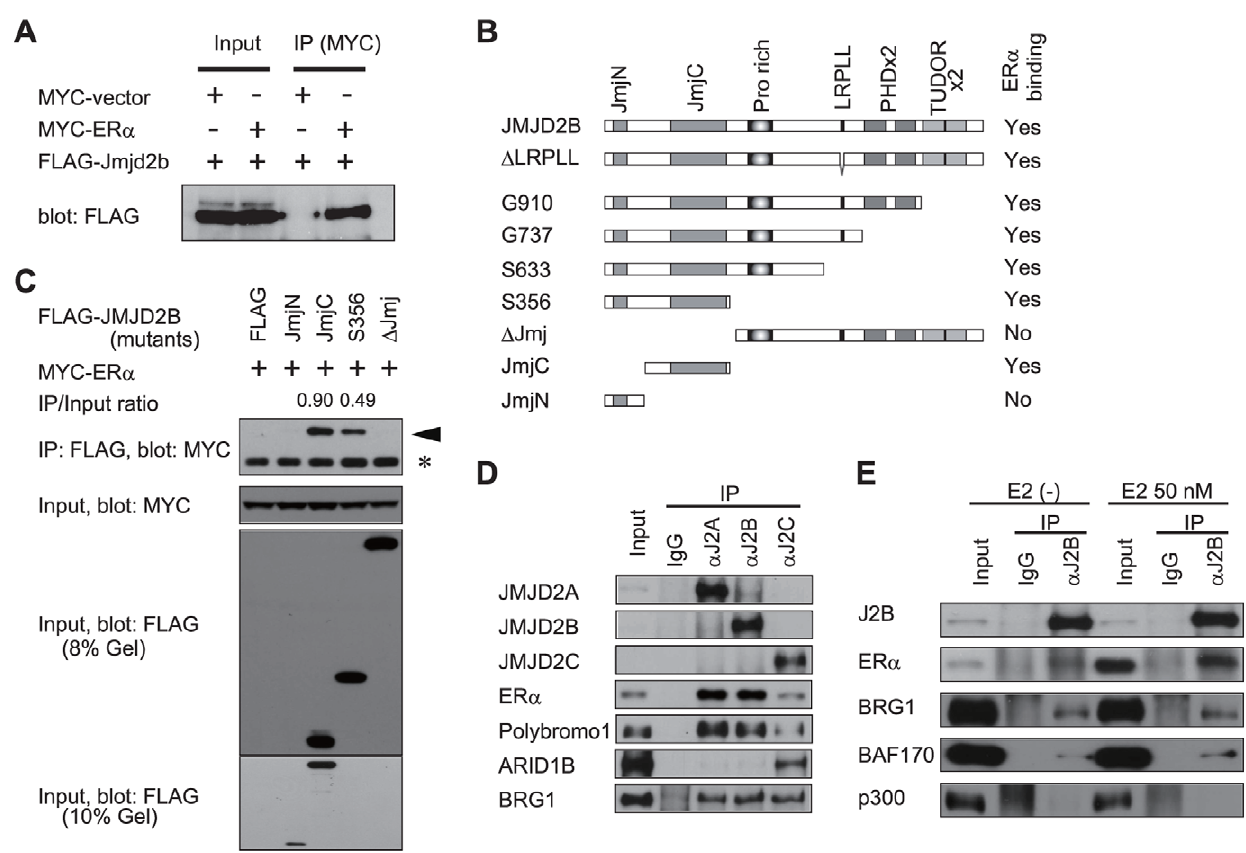
Figure 3. JMJD2B interacts with ER a and SWI/SNF-B complex. (A) JMJD2B co-immunoprecipitates with ER a . 293T cells were co-transfected with expression plasmids for FLAG-JMJD2B and either MYC-ER a or empty vector. Cell lysate and a -MYC immunoprecipitates were analyzed by western blot with a -FLAG antibody. (B) Structure of JMJD2B deletion mutants. Pro rich, proline rich region. LRPLL, LRPLL motif. PHDx2, double PHD domain. TUDORx2, double TUDOR domain. Western blot analysis of mutants is shown in Figure S3A. (C) The JmjC domain is sufficient for co- immunoprecipitation with ER a . 293T cells were co-transfected with MYC-ER a and individual JMJD2B deletion mutant expression vectors (refer to B). Cell lysates and a -FLAG immunoprecipitates were analyzed by western blot with antibodies to the indicated proteins. Relative intensity of the bands of the mutants is shown, normalized to the bands of corresponding input. Arrowheads, ER a bands; *, a -FLAG antibody. (D) Association of JMJD2 proteins with ER a , SWI/SNF complex, or SWI/SNF-B complex. (E) Association of JMJD2B with ER a or SWI/SNF-B complex in the absence or presence of estrogen simulation. (D and E) Nuclear lysates of T-47D cells were immunoprecipitated with control IgG or antibodies to the indicated proteins. Input lysate and immunoprecipitated samples were immunoblotted using antibodies to the indicated proteins. See also Figure S3. Full-length blots are in Figure S7.